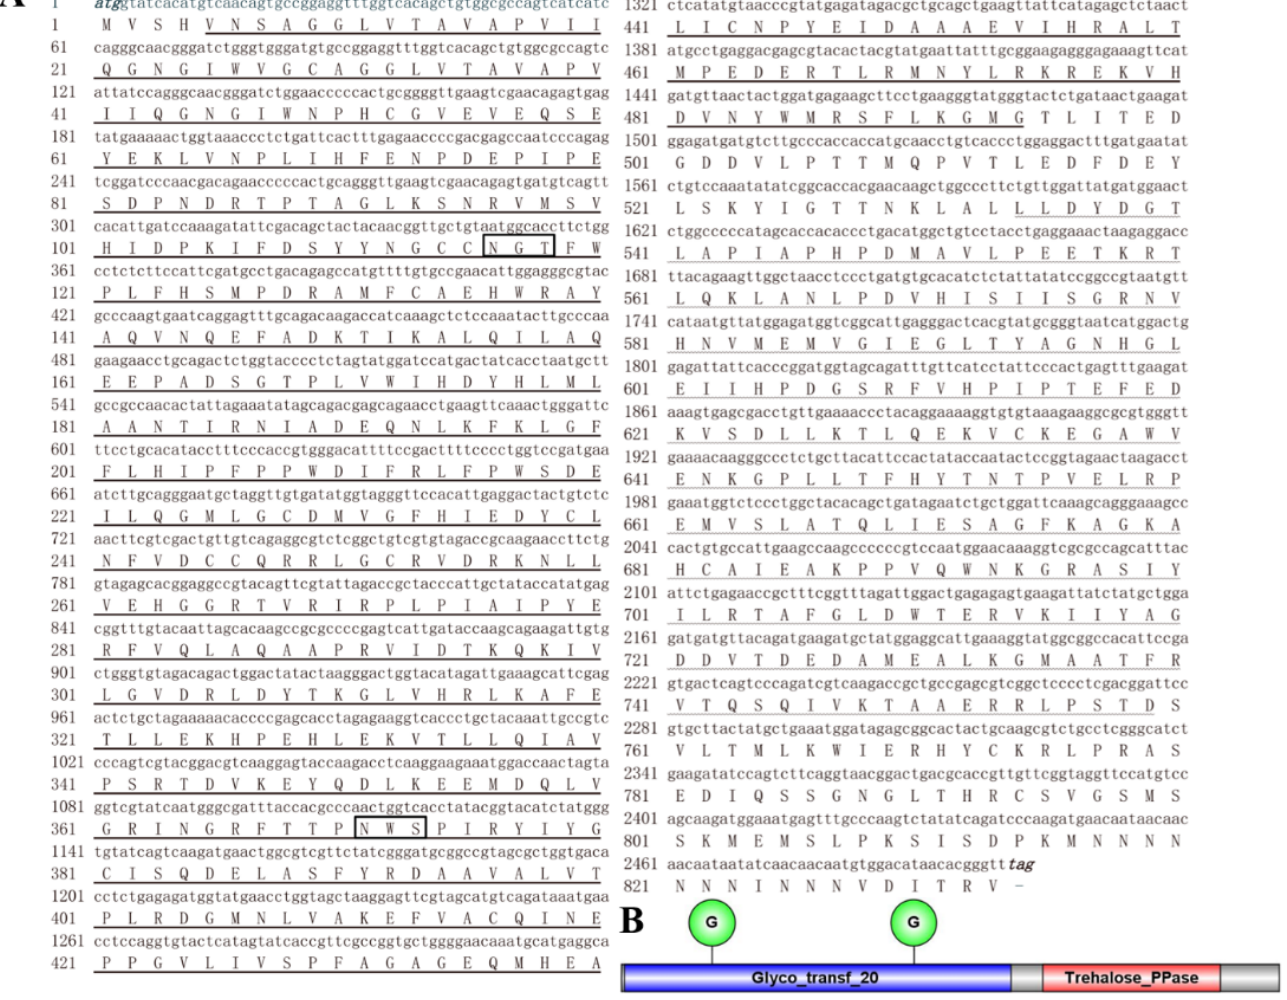
Figure 1. Sequence analysis of DcTPS1 cDNA sequence. ( A ) Nucleotide and amino acid sequence analysis of the DcTPS1 cDNA sequence. Numbers on the left side indicate the position of nucleotide and amino acid. The initiation codon (ATG) and termination codon (TAG) are showed in bold italics. The black solid line indicates the Glyco_transf_20 domain. The black break line indicates the Trehalose_PPase domain. The black box represents two glycosylation sites. ( B ) Structural domain analysis of DcTPS1 by SMART software. The blue box represents Glyco_transf_20 domain. The red box represents Trehalose_PPase domain. Two green circles indicate the glycosylation sites.